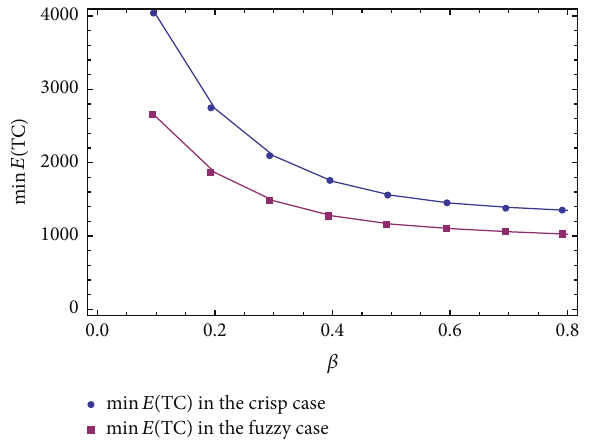
Figure 2: The comparison between the crisp and fuzzy cases for Exponential at 𝛾 = 0.7